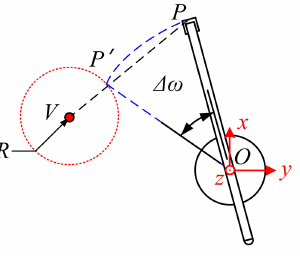
Figure 8. Collision urgency evaluation for horizontal